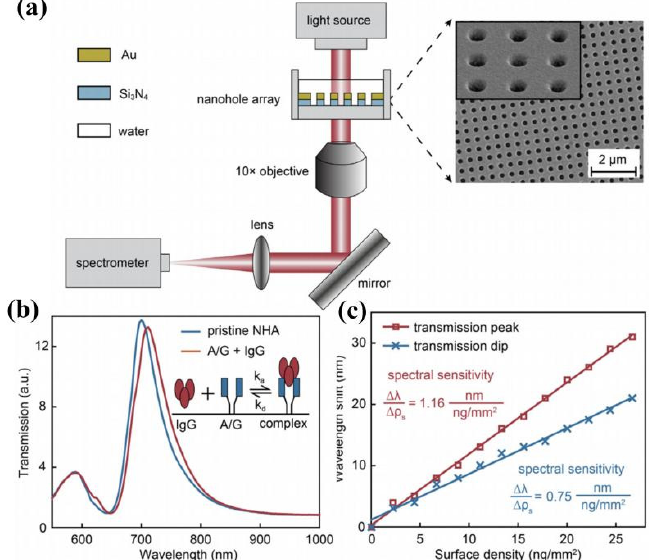
Figure 8. ( a ) Schematic diagram of the experimental setup for biomolecular detection based on Fano resonance. Adapted with permission from Ref. [127]. Copyright (2020), 2020 Elsevier B.V. ( b ) Experimentally measured transmission spectra with different tested materials on the NHAs. ( c ) Sensitivities of the Fano EOT transmission dip and peak. Table 1. Examples of Fano resonance biosensors.